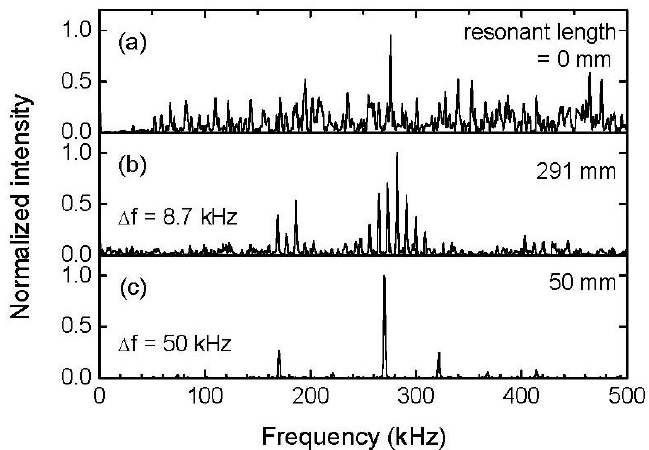
Figure 6. Frequency characteristics of the FBG sensor responses depicted in Figure